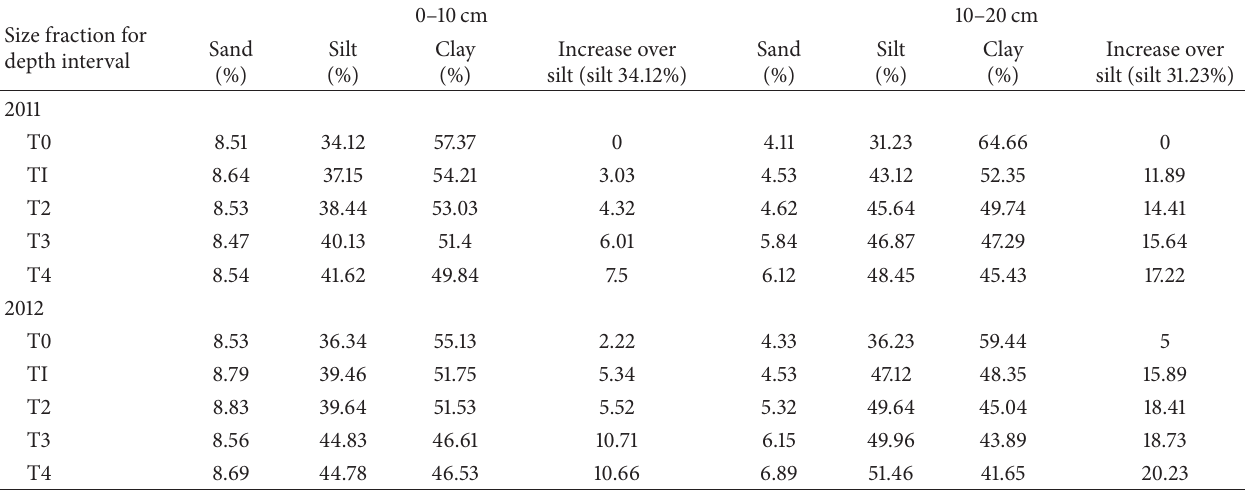
Average of triplicate measurements.